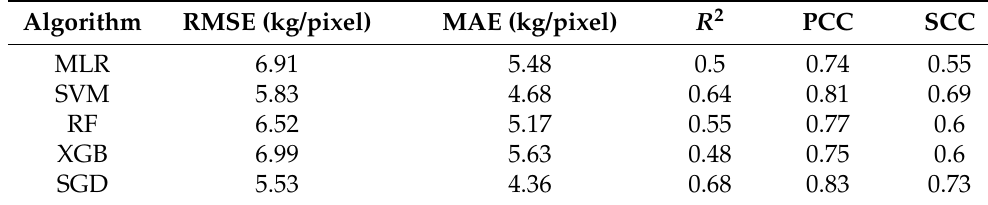
Table 4. Performance of ML models with the new PPI methodology for